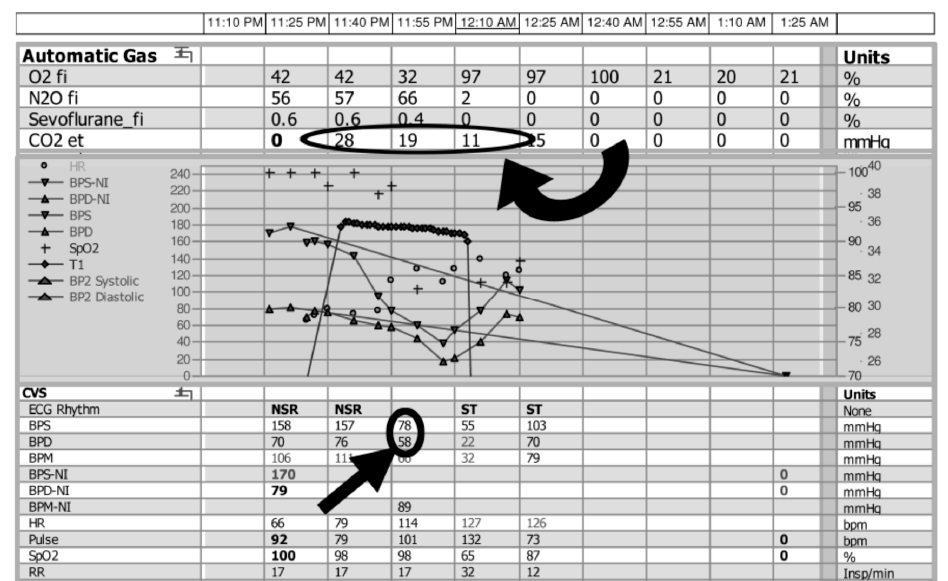
Figure 3. Changes in end-tidal CO 2 monitoring during intraoperative air embolism from the anesthesia record of a 76-year woman undergoing hemicraniectomy for traumatic intracranial hemorrhage. Approximately 5 min after the cranium was opened, a sudden decrease in end-tidal CO 2 was noted (circled, curved arrow) followed by a rapid decrease in both the systolic (BPS) and diastolic (BPD) blood pressure (circled, straight arrow). Immediate measures were taken, including lowering the head and flooding the field with water. However, 3 min after the change in CO 2 was detected, the patient suffered a pulseless electrical activity (PEA) cardiac arrest, and expired 1 h later despite resuscitative measures.